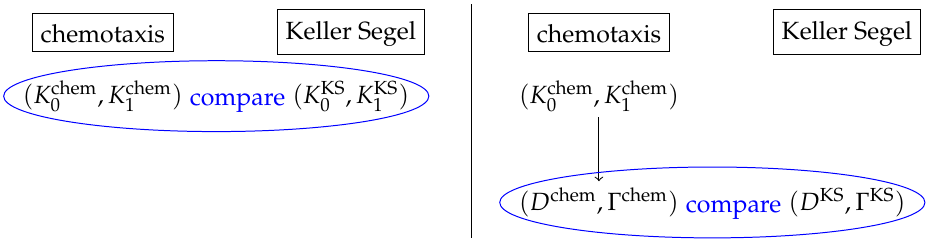
Figure 1. Two ways to compare the inverse problems: determining and comparing the tumbling kernels for both underlying chemotaxis and Keller–Segel models (left) or determining the drift or diffusion coefficient for the Keller–Segel model and the tumbling kernel for the chemotaxis model and calculating the corresponding drift and diffusion coefficients.